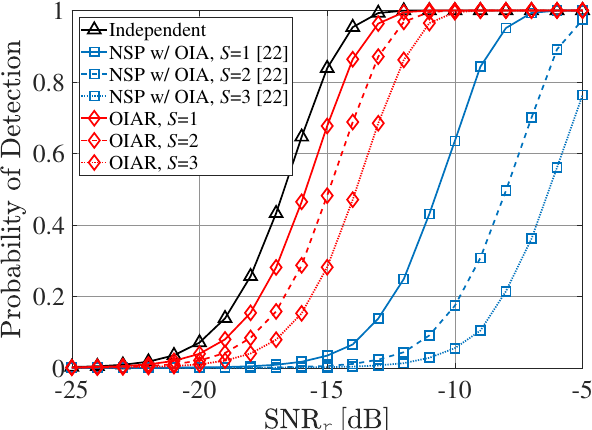
Figure 3. Radar probability of detection according to SNR r with different S .